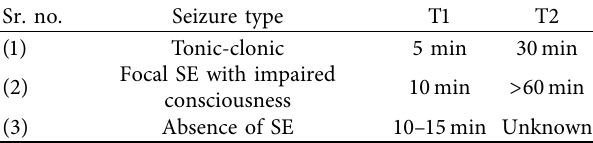
Table 1: Timeframe for SE as per the ILAE guidelines